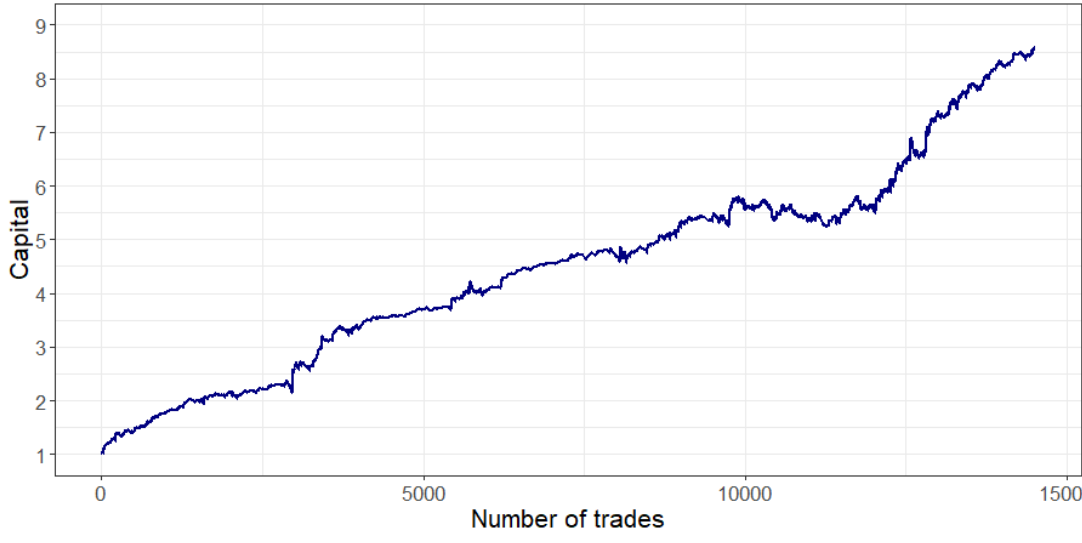
Fig. 10. Cumulative overall return of our basic statistical arbitrage strategy applied to the two- hour timeframe over the whole sample period. Trade size is fixed, meaning that gains are not